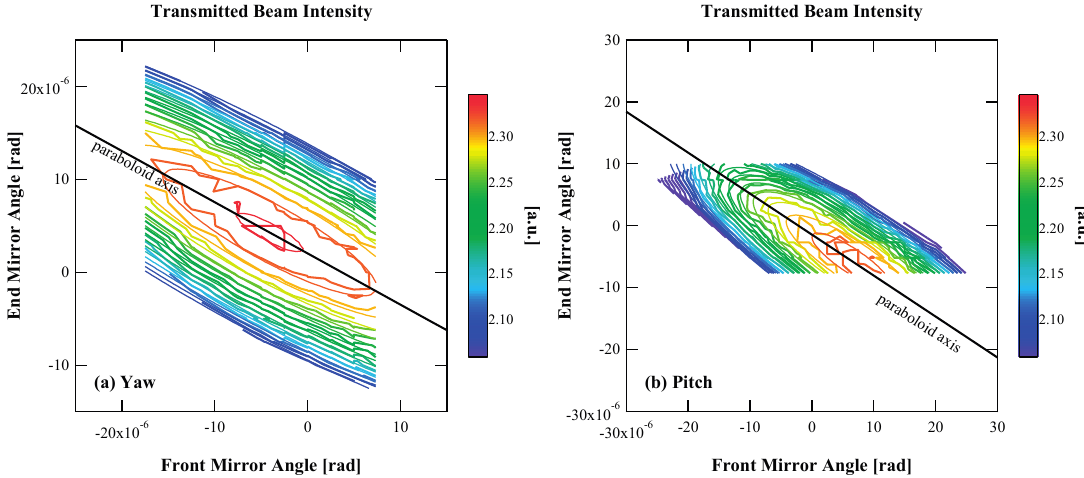
Figure 9. Transmitted beam intensity (actual measurements). The intensity of the beam transmitted from the cavity was monitored by the photo detector located behind the end mirror. These maps were acquired by misaligning the mirrors intentionally in yaw ( a ) and pitch ( b ) directions. The thick contours are drawn by using measured data, and the thinner ones are the results from paraboloid fitting. These measurements were repeated several times to determine the skew angles and to validate the model